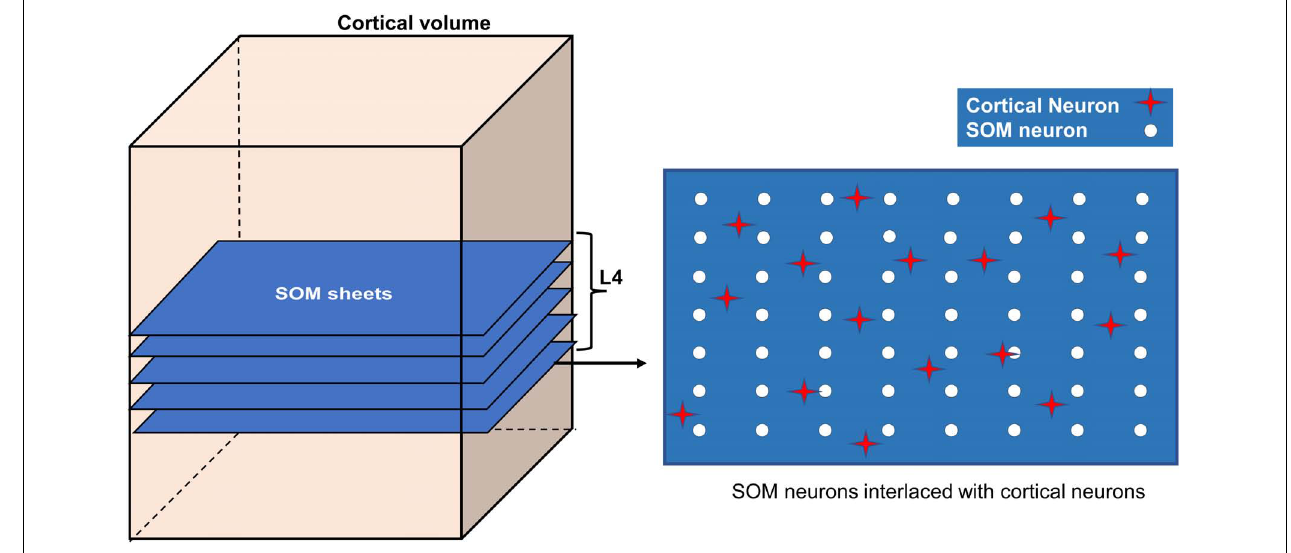
FIGURE 3 | Incorporating SOM in VAM to form A-VAM.